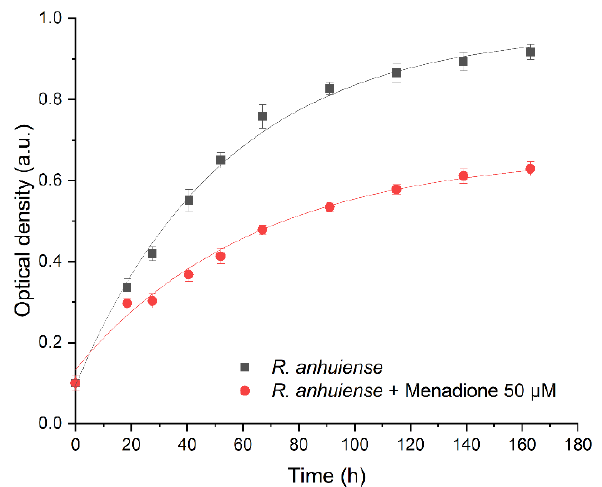
Figure 1. Growth curve optical density (OD) values of (•) Rhizobium anhuiense bacteria and (▪) Rhizobium anhuiense bacteria with 50 µ M of menadione in Norris medium. Data approximated according to exponential function y = y 0 + A 1 e − ( x − x 0 ) / t 1 , where: (i) y 0 = 0.97, x 0 = 0.56, A 1 = − 0.87, and t 1 = 54 for Rhizobium anhuiense bacteria; (ii) y 0 = 0.67, x 0 = 3.28, A 1 = − 0.51, and t 1 = 64 for Rhizobium anhuiense bacteria with 50 µ M of